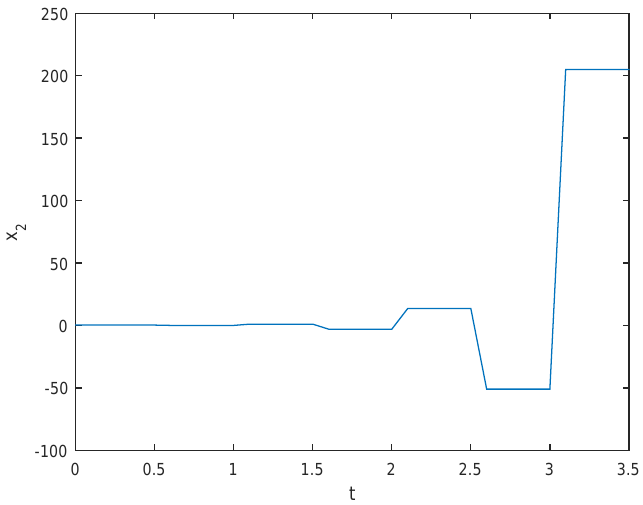
Figure 2. The unstable behavior of the state variable x 2 ( t ) of the model (6) with impulsive perturbations